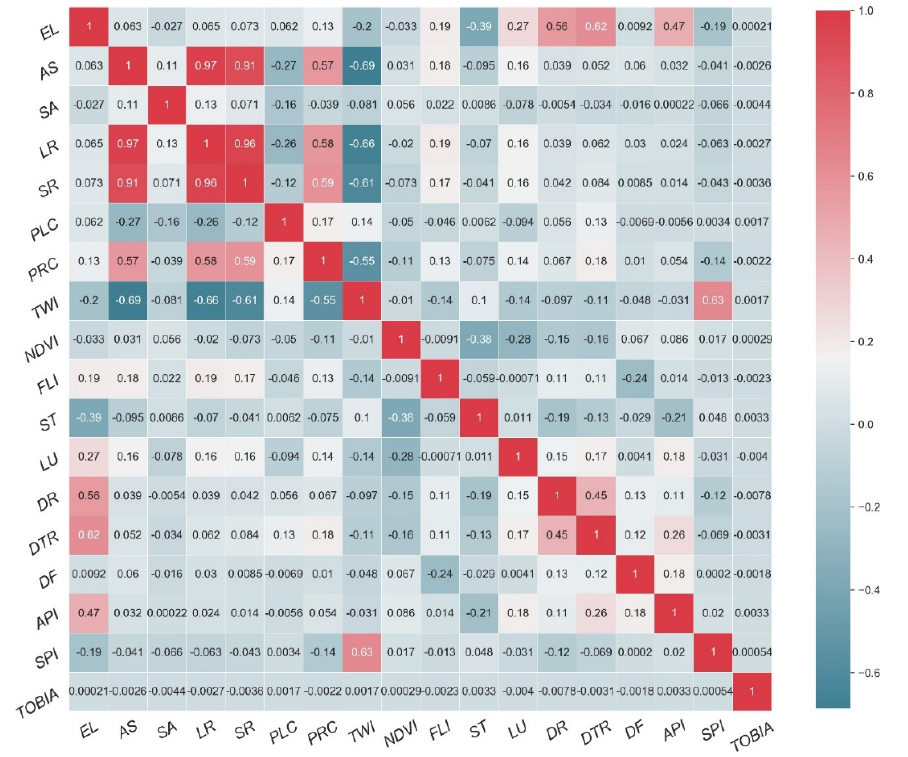
Figure 5. Heat map of the parameter correlation matrix. The color value of right strip from high to low indicates the tightness of factor correlation.